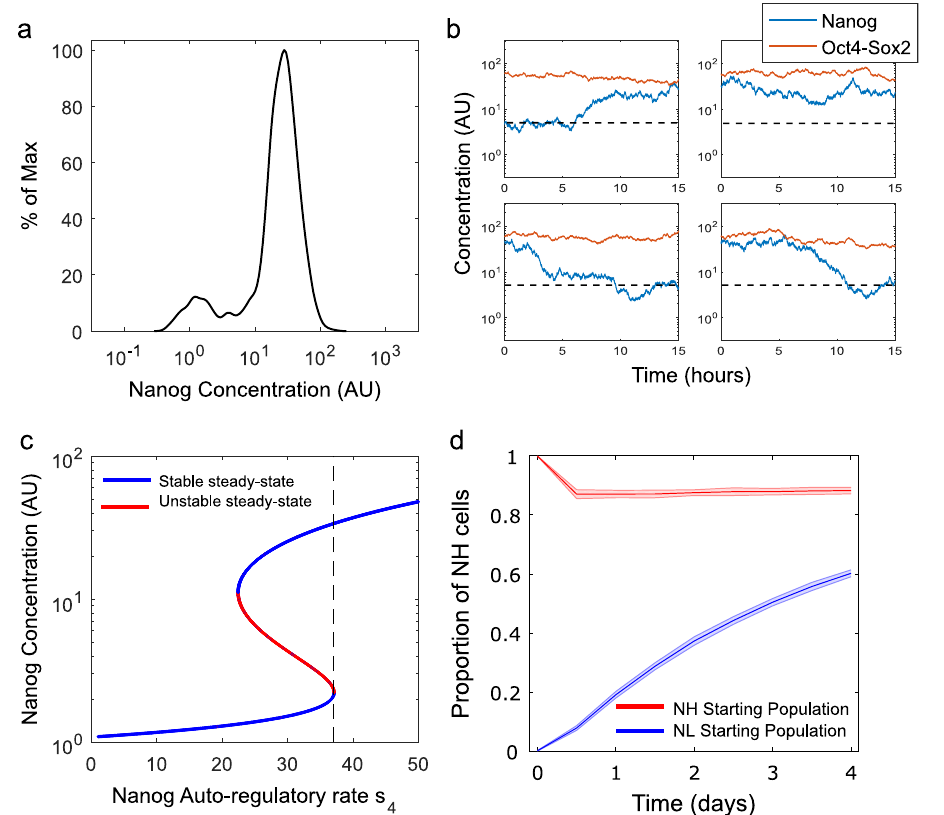
Fig. 3 System dynamics and stability in 2i/LIF (PD = Chiron = 2 AU, Nanog transcriptional noise reduced by 20%) a Steady-state distribution of Nanog simulated in 1000 cells, showing that approximately 90% and 10% of the cells are in the NH and NL states, respectively. b Four representative time-course simulations of Nanog ( blue line ) and Oct4-Sox2 ( red line ) in single cells over 15 h. Similarly to the serum/LIF case, Oct4-Sox2 dimer concentration remains fairly constant compared to Nanog. The horizontal black dotted line represents the threshold between NH and NL. c Continuation of Nanog steady-state for the deterministic system (no noise). Blue lines are stable steady-states, while the red line is unstable. The maximal transcription rate, s 4 ( dotted black line ), intersects both NH and NL steady-states, though is very close to the saddle-node bifurcation. d Sorting simulation: 1000 cells in the NH or NL state are simulated over 4 days, and the proportion of cells in the NH state is recorded every 12 h ( n = 10, shaded areas indicate standard deviation). Cells restore the steady-state distribution of approximately 90% NH and 10%